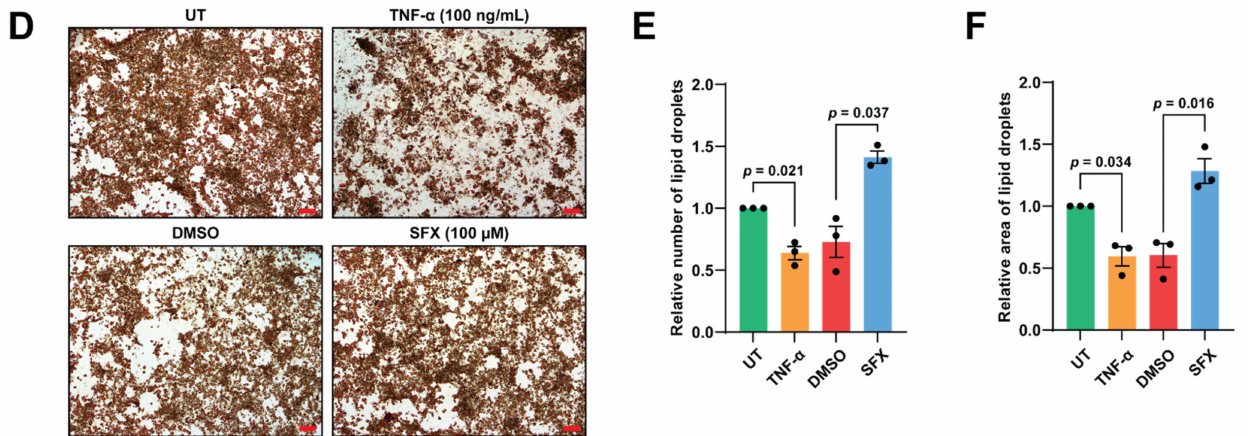
Figure 3. SFX reduces the loss of lipid droplets induced by C26 conditioned medium (CM) in vitro. ( A ) Schematic representation of the differentiation of pre-adipocytes to adipocytes using differentiation and maintenance medium. ( B ) Cells that were fully differentiated into adipocytes were stained with Oil Red O. First column: undifferentiated pre- adipocytes. Second column: differentiated adipocytes showing lipid droplets under a phase contrast microscope (purple staining represents hematoxylin). Magnification of 10 × , scale bar: 200 µ m. ( C ) Schematic representation of the cell culture, drug treatment and collection of CM. C26 cancer cells were cultured in DMEM medium with SFX (100 µ M) or vehicle alone for 48 h. Following PBS wash, C26 cancer cells were incubated in DMEM complete medium for 24 h to produce CM. ( D ) Oil Red O lipid staining under a phase contrast microscope upon incubation with DMEM complete medium (untreated), 100 ng/mL TNF- α (positive control), C26 SFX, or vehicle alone treated C26 CM treatment for 48 h. Magnification of 10 × , scale bar: 200 µ m. ( E , F ) Dot plots representing quantification of the relative total number and area of lipid droplets, respectively, using ImageJ. All data are representing mean ± SEM. Statistical significance was examined by paired two-tailed Student’s t -test, n = 3 biologically independent